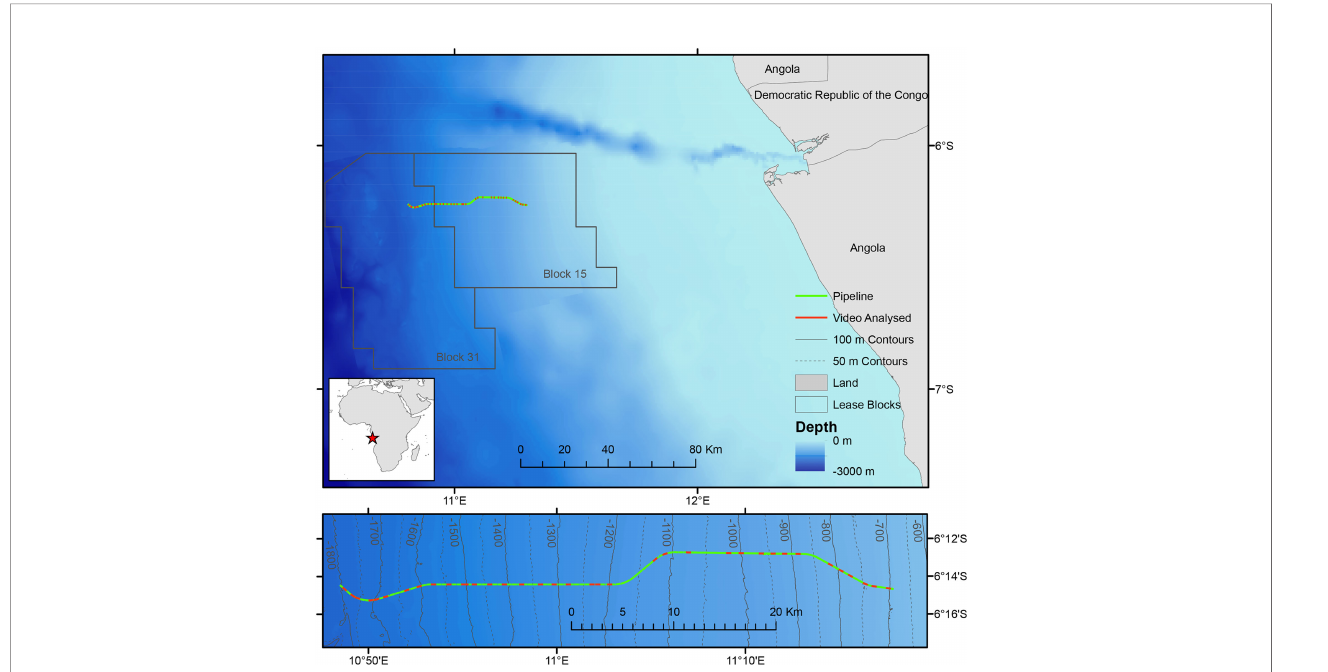
FIGURE 1 | Map showing the location of the survey area in Angola. Contours marked on lower detailed map. Red star on inset map indicates position of survey in west